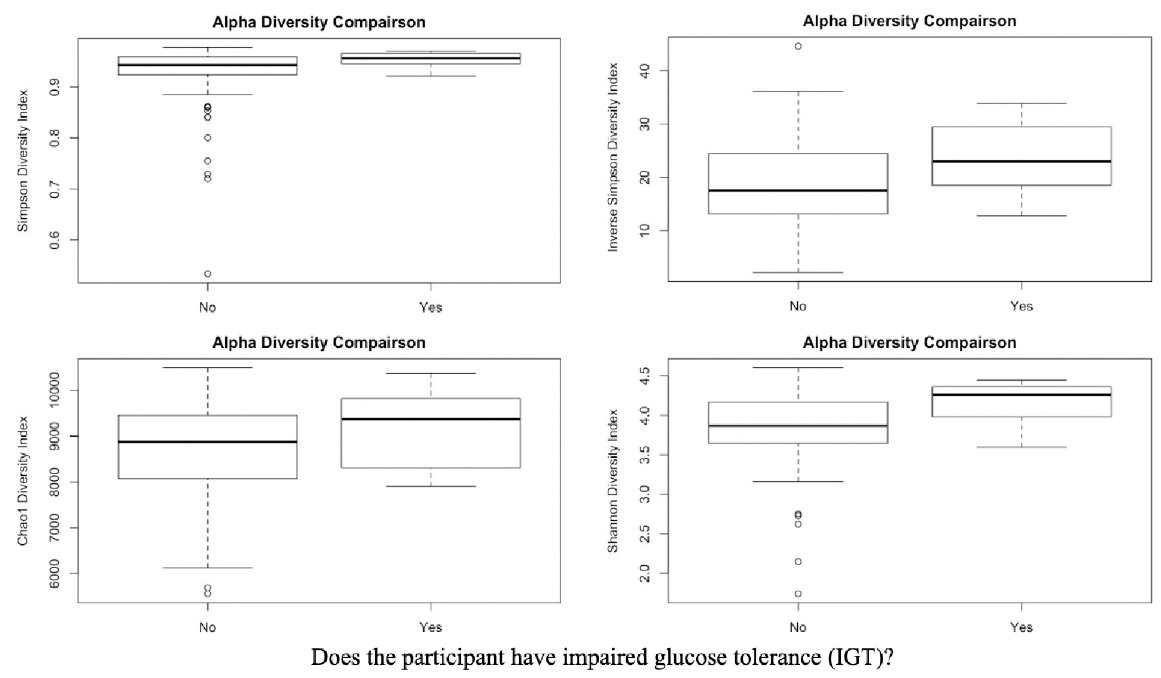
Fig 2. Boxplots comparing alpha diversity metrics between impaired and normal glucose tolerance.